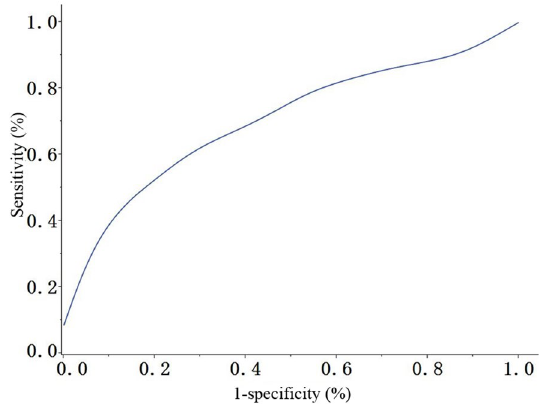
Figure 1. Receiver operating characteristic curve of HE4 for diagnosing EC. χ 2 = 30.951, P < 0.001.